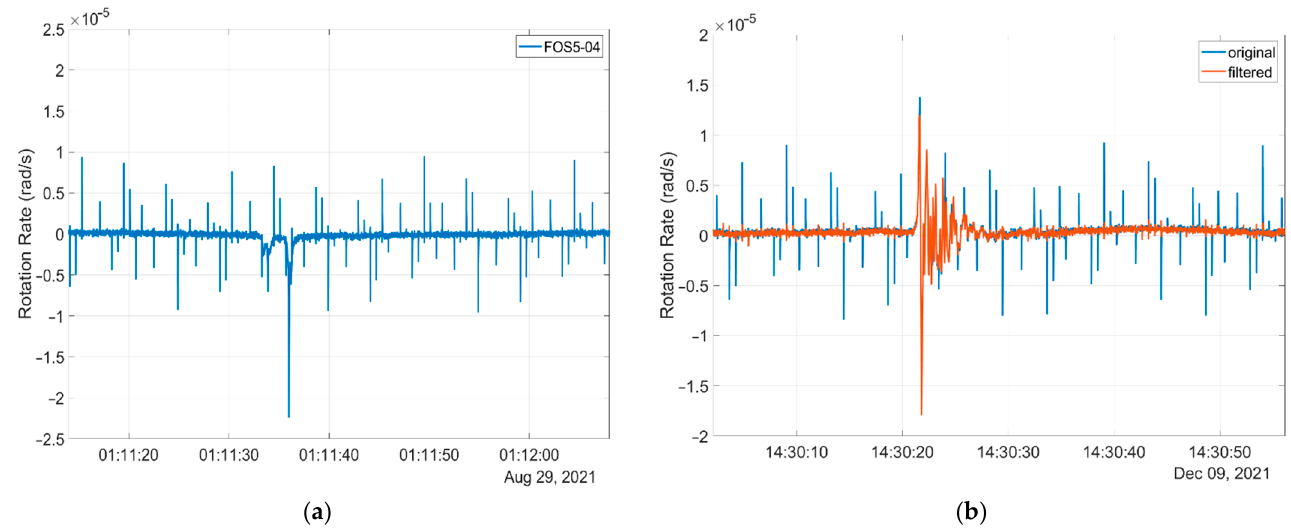
Figure 9. Seismogram recorded by the FOS5-04: ( a ) existence of a series of unrecognised artefacts, and ( b ) result of an application of the latest algorithm for artefact “dumping”.